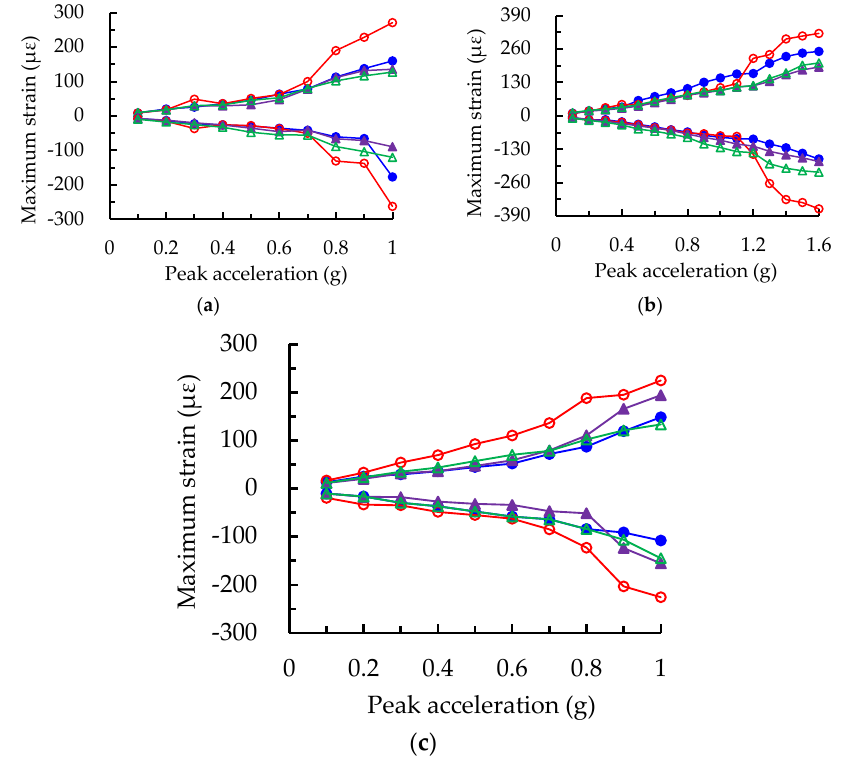
Figure 23. Maximum strains of the flange at the end of the frame beam subjected to the different intensity levels. ( a ) El Centro wave; ( b ) Kobe wave; ( c ) Taft wave.